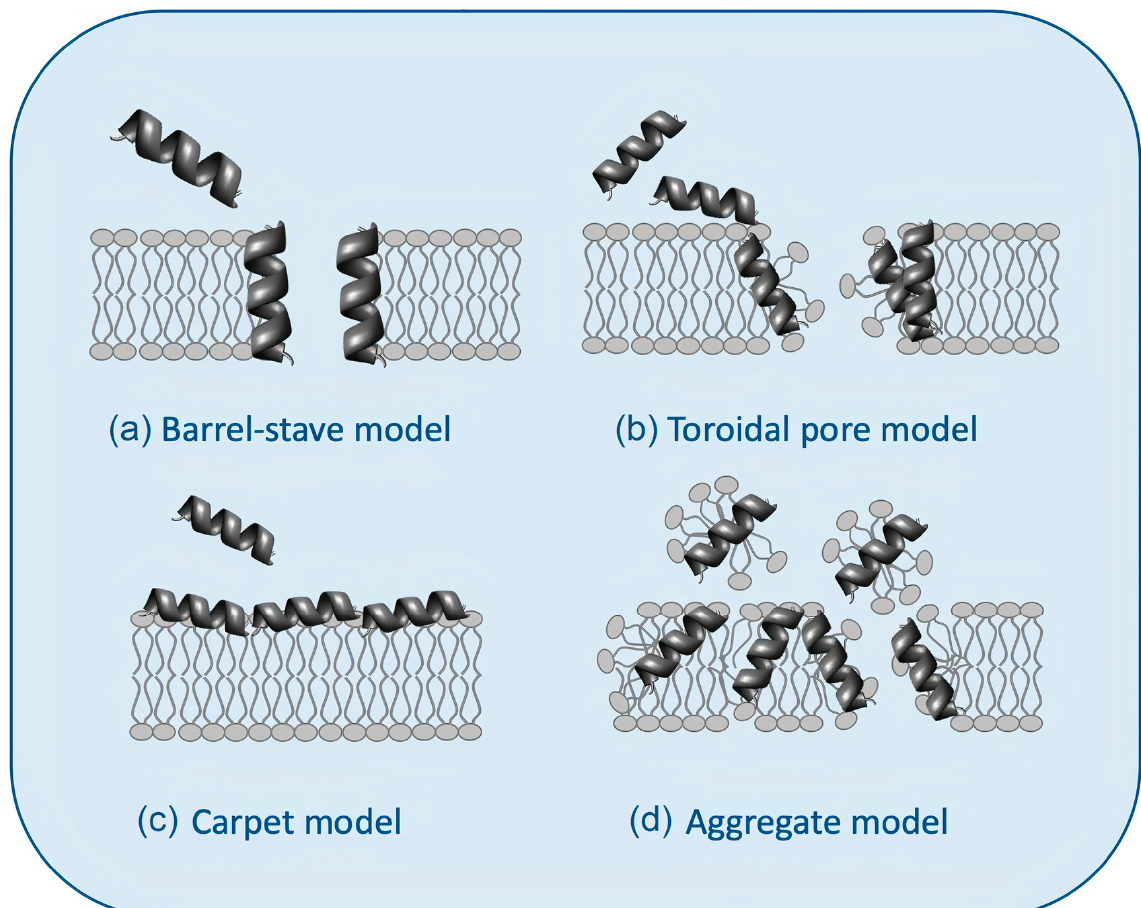
Figure 3. Models for the interaction between antimicrobial peptides (AMPs) and bilayer membranes: ( a ) the barrel − stave model, ( b ) the toroidal pore model, ( c ) the carpet model, and ( d ) the aggregate or “detergent − like” model was adapted from [60].